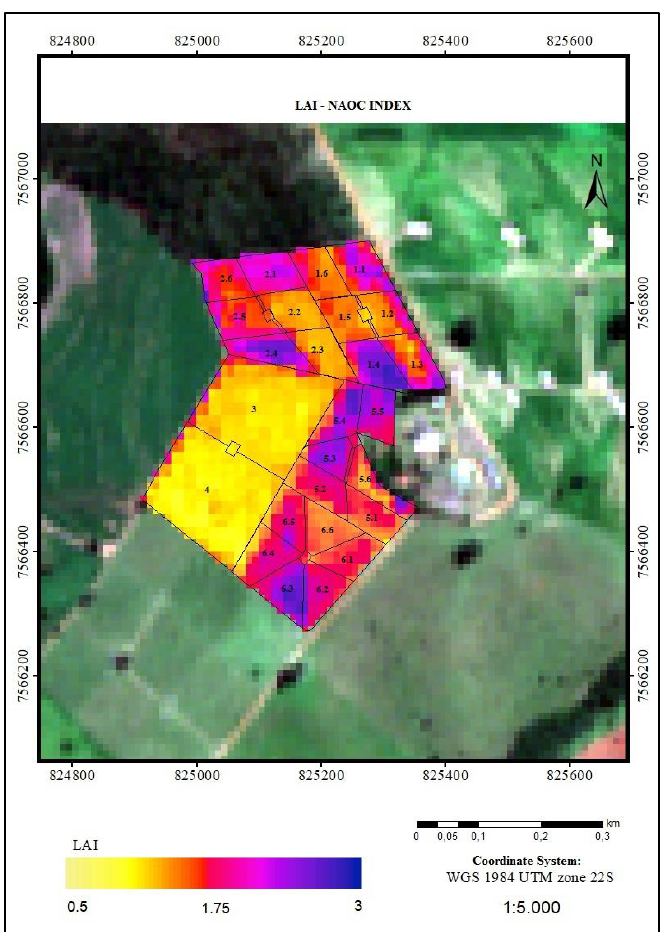
Figure 13. LAI (m 2 m − 2 ) map with 20 m spatial resolution estimated with Equation (3) applied on the Figure 13 . LAI (m 2 m −2 ) map with 20 m spatial resolution estimated with Equation 3 applied on the Sentinel-2 image of 25 April 2018, over Piat ã and Decumbens grassland Sentinel-2 image of April 25, 2018, over Piatã and Decumbens grassland area.